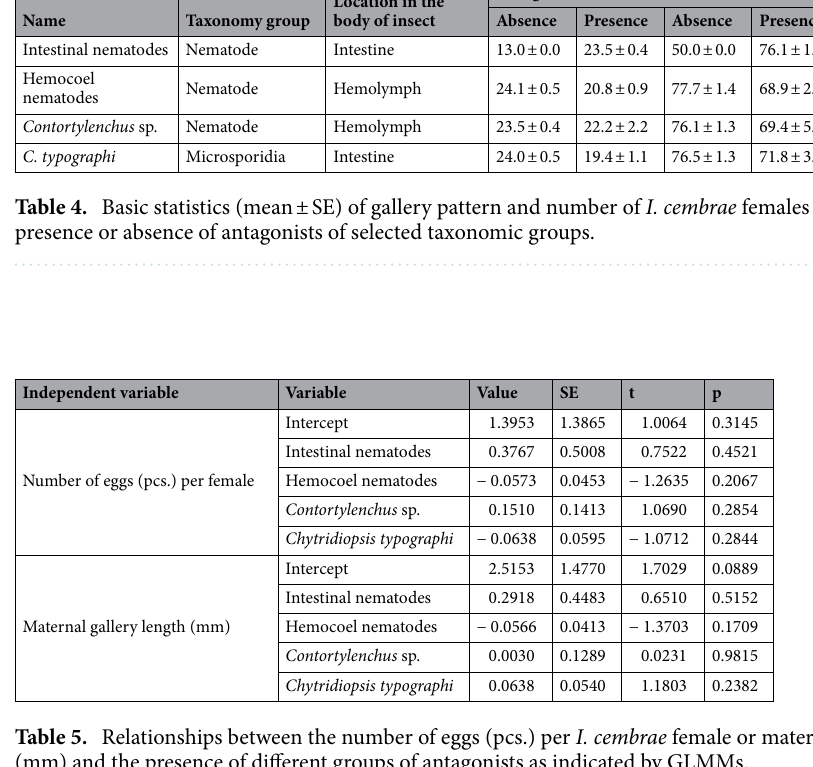
Antagonist specification No. of females [pcs.]